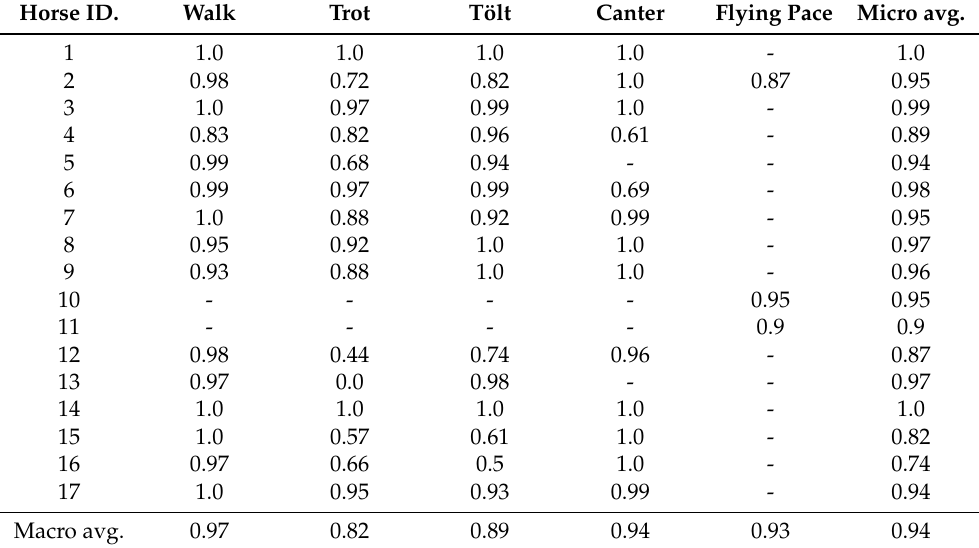
Table 6. We performed cross-validation where each horse was left out. For each horse, we ran the evaluation with five different initializations of the Bi-LSTM model and report the micro average for each gait. The macro average over all the gaits is 0.91. The amount of training data for each horse can be found in Table